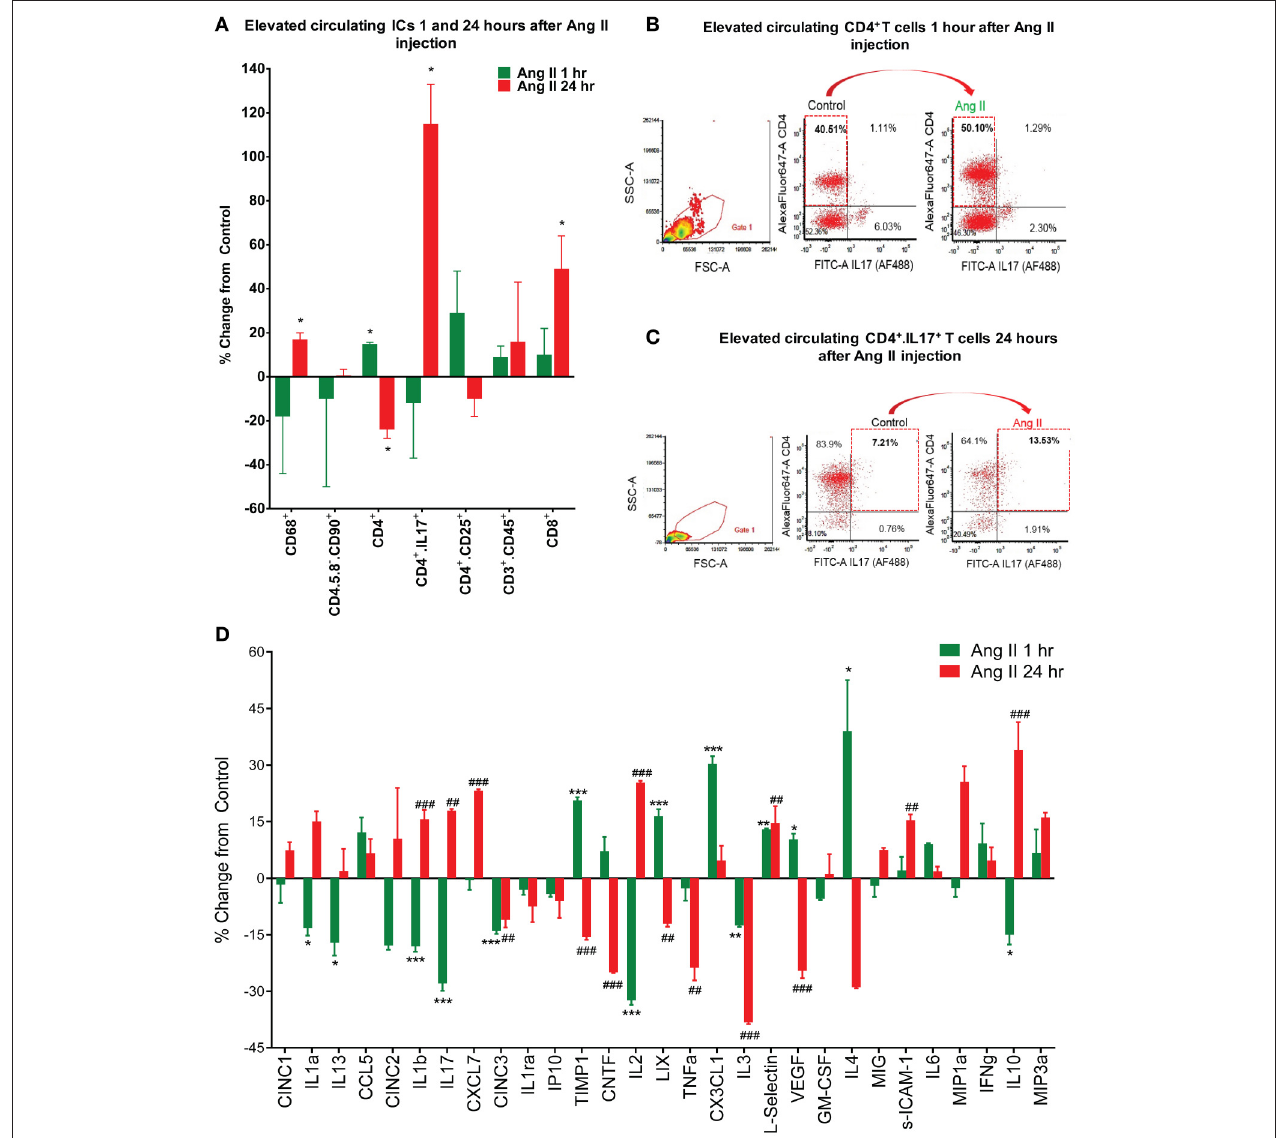
FIGURE 2 | Effects of systemic Ang II injection on peripheral and central immune response. (A–C) Quantification of circulating inflammatory cells show an increase in CD4 + T cells even at 1 h post-Ang II injection (A,B) and persistence of CD4 + /IL17 + T cells, amongst others, at 24h post-Ang II injection (A,C) . In (D) , changes in PVN cytokine levels following a single Ang II injection I.P., as measured by ELISA at 1h (green bars) and 24h (red bars) following the injection. ± SEM. N = 4–6 per group, * P < 0.05, ** ## P < 0.01, *** ### P < 0.001, vs. respective control. ICs, inflammatory